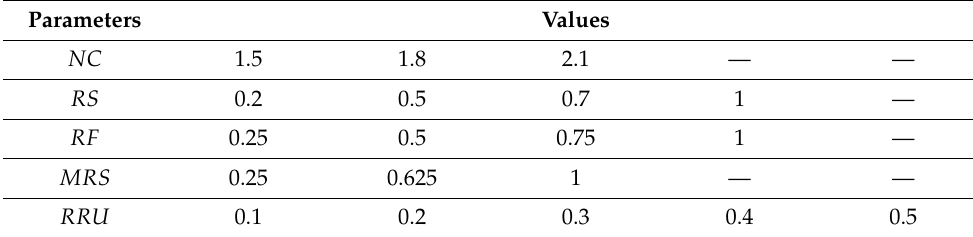
Table 6. Parameters and